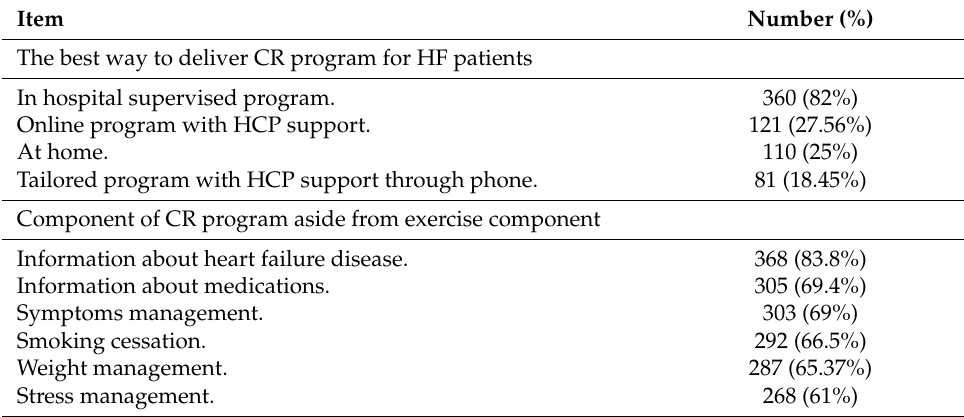
Table 3. Mode of delivery and component of cardiopulmonary rehabilitation ( n = 439).